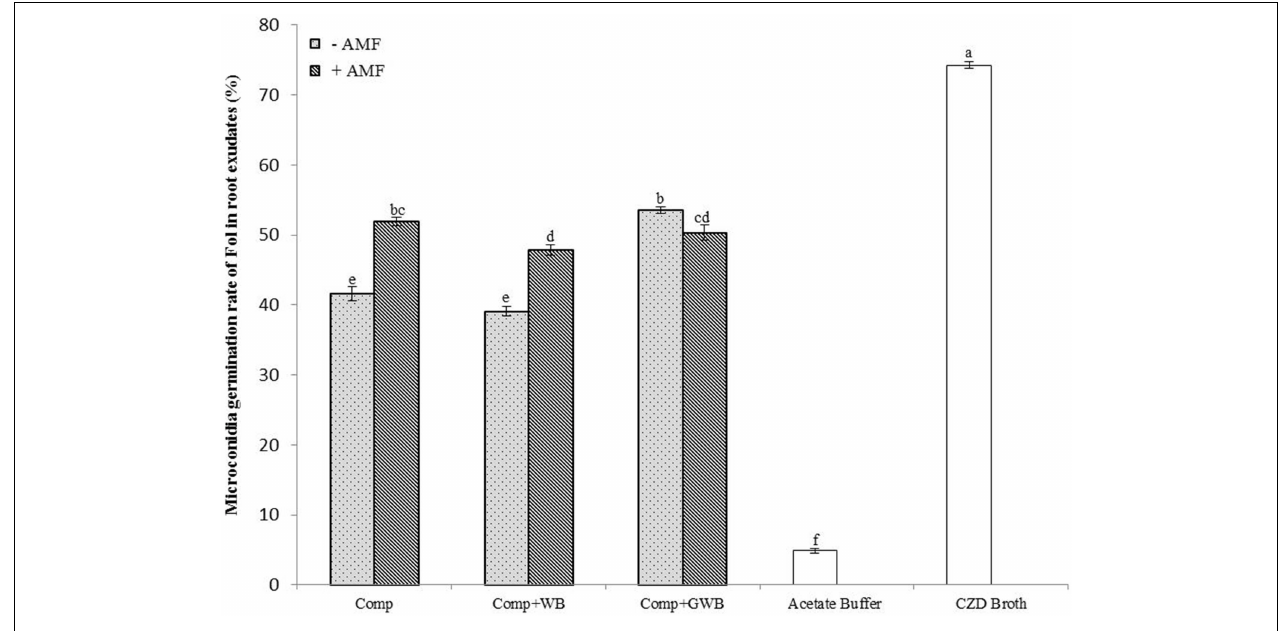
AMF ( − AMF) after 20h at 24 ◦ C. Each bar represent mean ± SE ( n = 9 ). Bars with no pattern represent microconidia germination in acetate buffer and Czapek dox medium (CZD). Different letters above bars indicate significant differences according to Tukey’s test ( P <